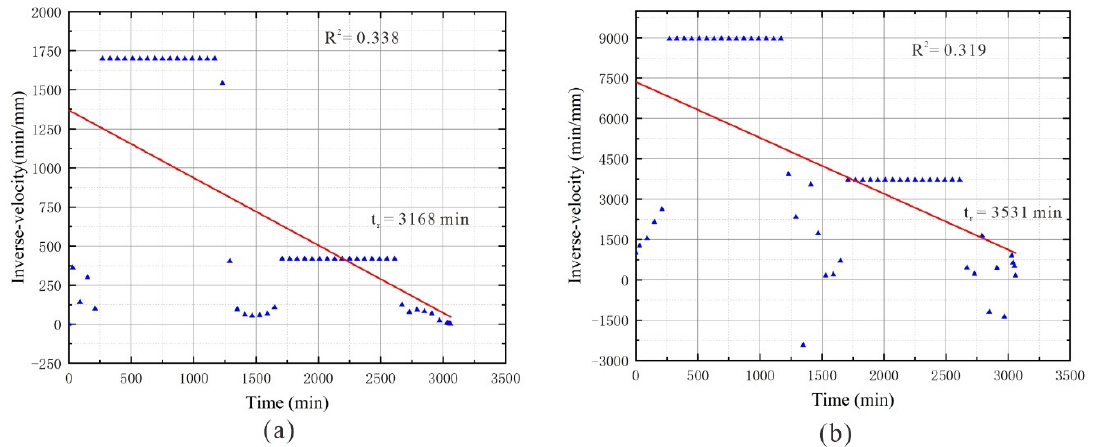
Figure 10. Typical plots used to predict slope failure using the INV method: ( a ) slope front; and ( b ) slope side.